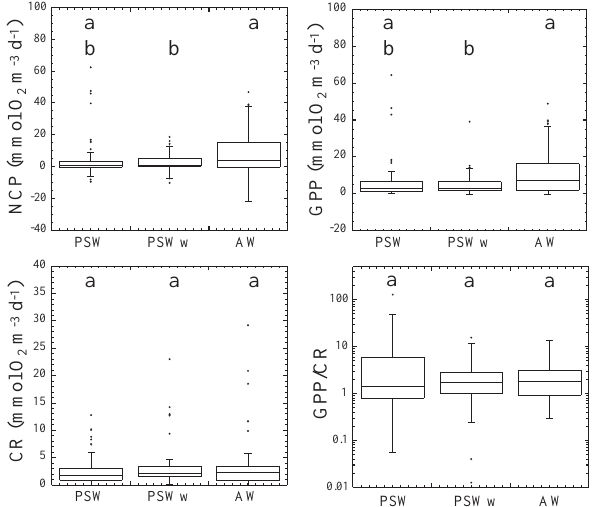
Fig. 4. Box plots showing the distribution of metabolic rates for the Figure 4 different water masses sampled here: (A) net community production (NCP), (B) gross primary production (GPP), (C) community respi- ration (CR) rates and (D) the ratio of GPP to CR. All rates reported inmmolO 2 m − 3 d − 1 . The boxes show the median of the metabolic rates plus the lower (25%) and upper (75%) quartiles, the whiskers indicate 1.5 times the interquartile range (IQR). Letters indicate the results for a Tukey HSD test, whereby the metabolic rate did not differ significantly for water masses with the same letter.